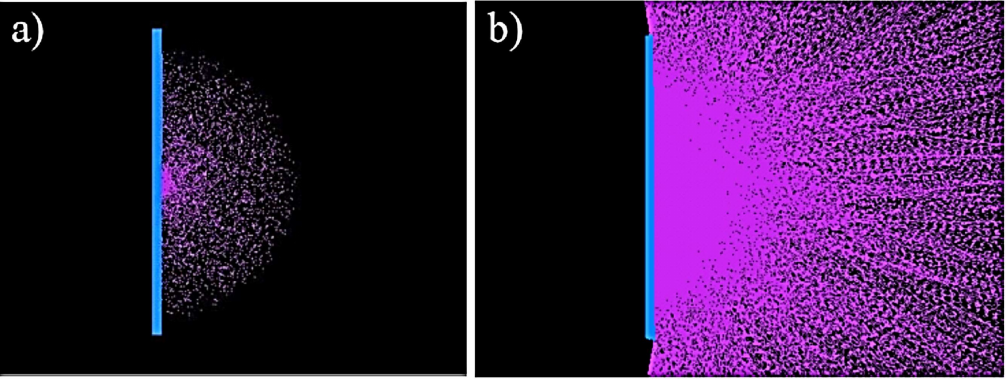
Figure 3. Model of: ( a ) Radioluminescence photons induced by alpha particles showing the hemisphere in which they are initially created by the alpha particles; ( b ) Showing the random directions in which the photons are emitted from the hemisphere in ( a ) and their longer path length—Using FRED Optical Engineering Software (Photon Engineering LLC) [11]. Reprinted with permission from the